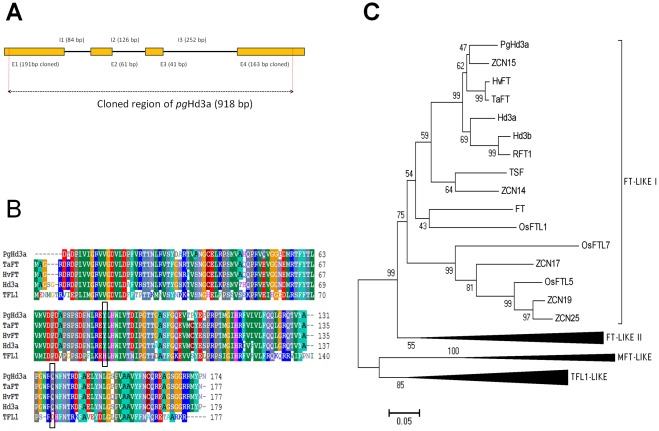
Structure of the pearl millet Hd3a orthologous and sequence similarity with PEBP family members.A. structure of the PgHd3a gene, E:exon and I: intron; the 918 bp fragment used in the population genetics analysis is shown between the two dotted red lines; the cDNA sequence was used to complete the 3′ region of the original sequence and to obtain the protein sequence. B. Multiple sequence alignment of the proteins of PgHd3a, the orthologous of FT (wheat (TaFT), barley (HvFT) and rice (Hd3a)) and TFL1; in the black boxes: the Tyr/His(88) and the Gln/Asp(145) residues which are essential to distinguish FT and TFL1. C. A neighborhood joining tree of the PEBP protein family in pearl millet (PgHd3a), maize (ZCN), rice (Os, RFT1, Hd3a, Hd3b), wheat (Ta), barley (Hv) and Arabidopsis (FT). The tree was built with the Poisson corrective distance [96] model. Robustness of nodes was tested on the basis of 1000 Bootstrap iterations.